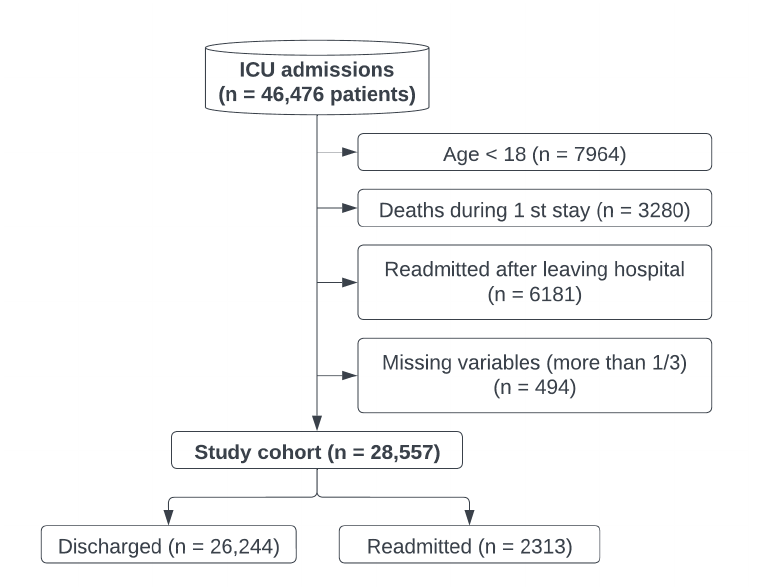
Figure 2. Cohort selection